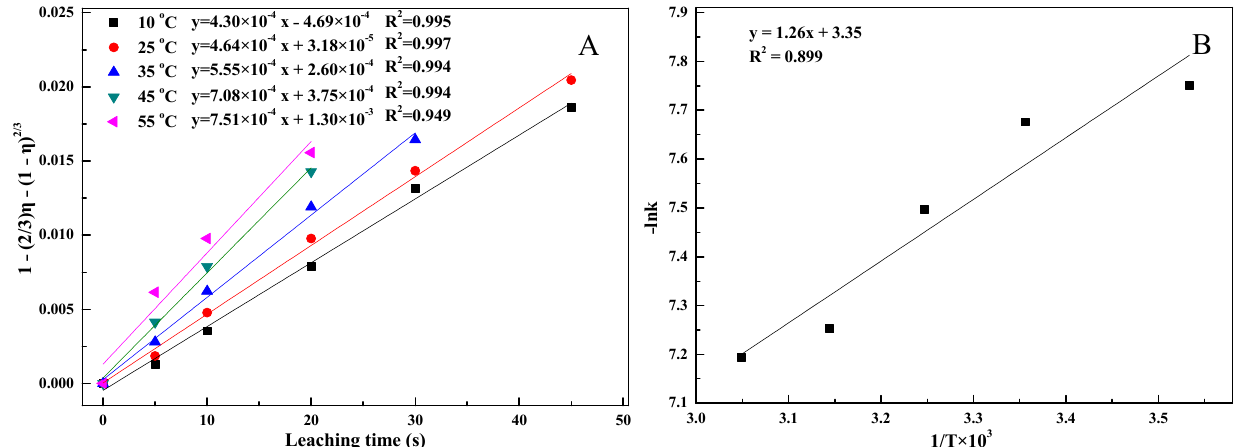
Figure 8. Effect of temperature on the leaching of aluminum (C 0 = 0.20 mol/L, stirring speeds 400 r/min).